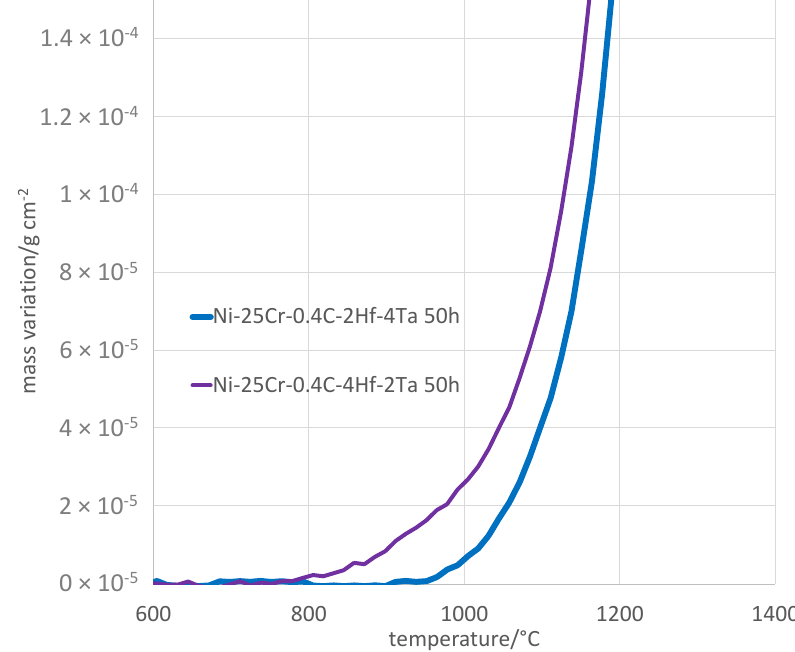
Figure 5. The two {m vs. t}-plotted curves of mass gain at heating for the two